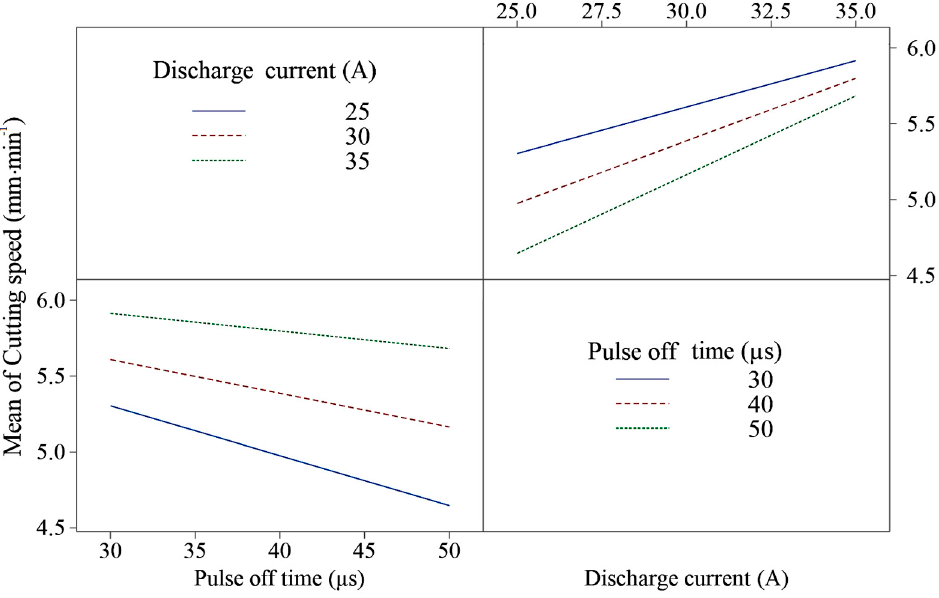
Figure 7. Interaction plot for discharge current and pulse off time.